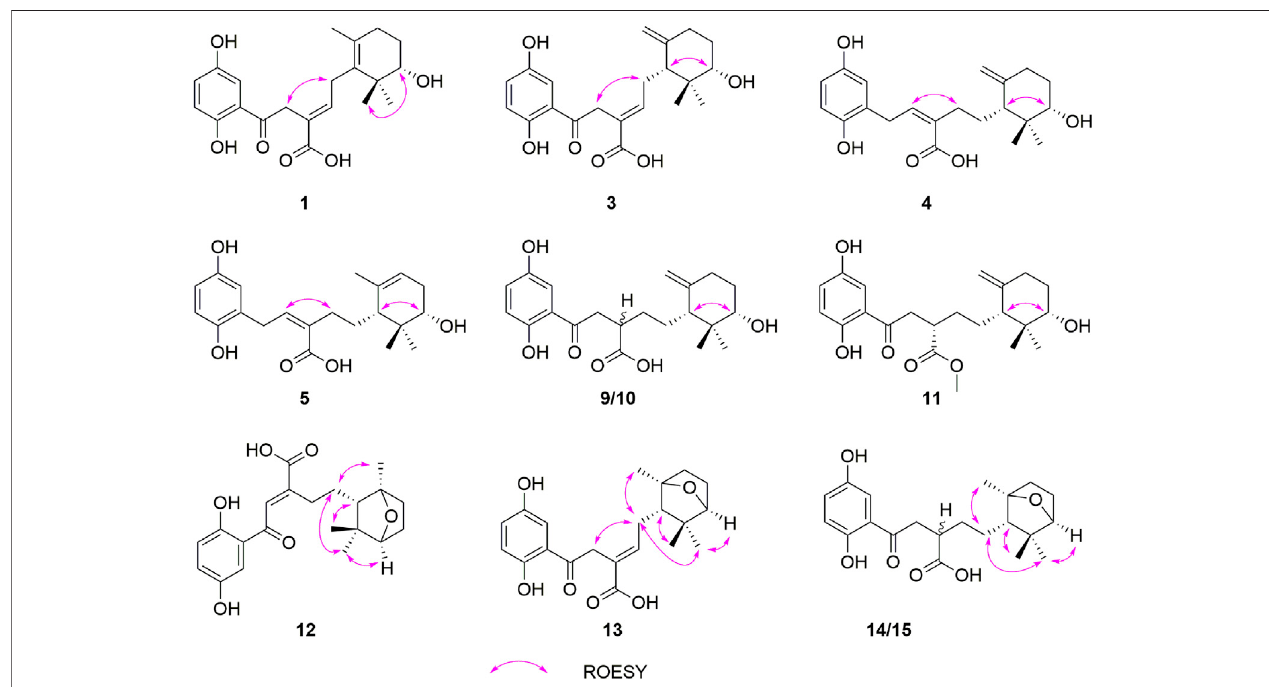
FIGURE 3 | Key ROESY correlations of 1 , 3 – 5 , 9 – 15